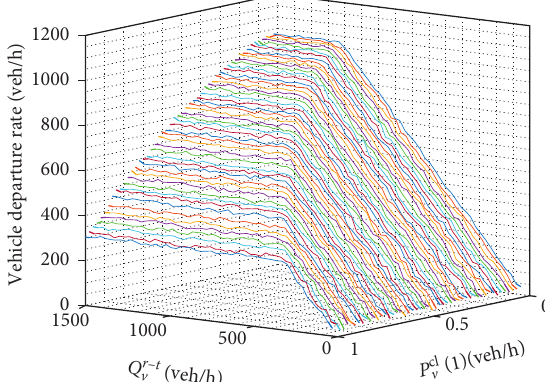
Figure 8: Relationship among C